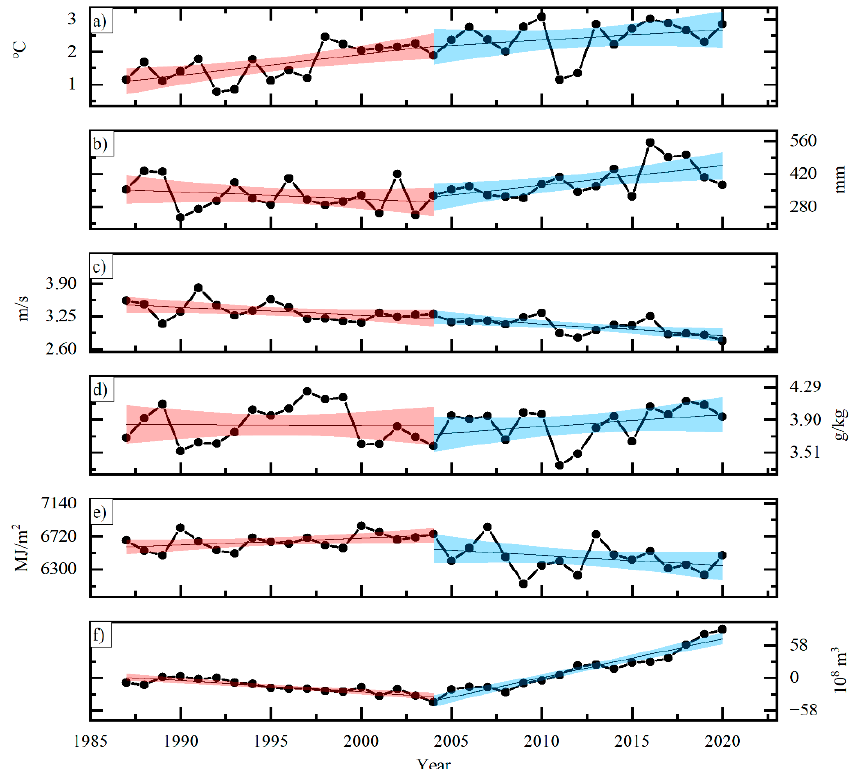
Figure 6. The variation of climate factors and lake area in Qinghai Basin during the period from 1987 to 2020. ( a ) average annual air temperature, ( b ) annual total precipitation, ( c ) average annual wind speed, ( d ) average annual specific humidity, ( e ) annual radiation, ( f ) lake storage anomaly. The pink area for 1987 to 2004, and the blue area for 2004 to 2020. The dashed lines are linear trends, respectively.